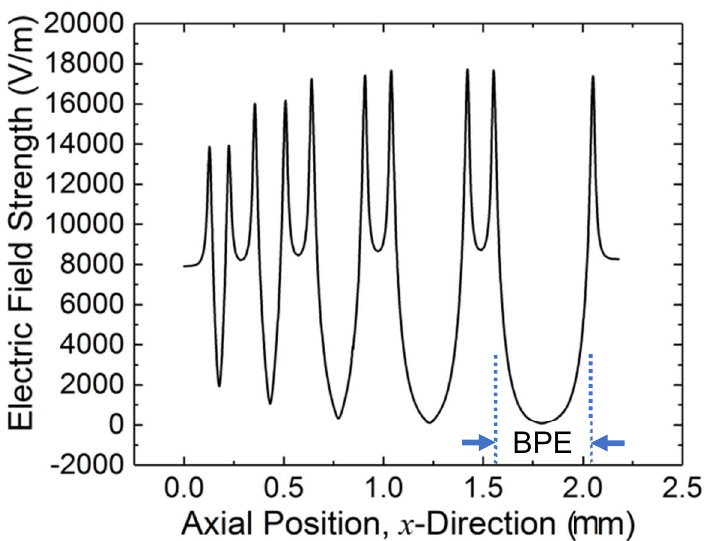
Figure 1. Simulated electric field norm along a 2D cut line taken along the x -direction at 9 µ m above the chamber floor across 100, 160, 275, 400, and 500 µ m-long BPEs. The position of the 500 µ m-long BPE is labeled with dashed lines for clarity.